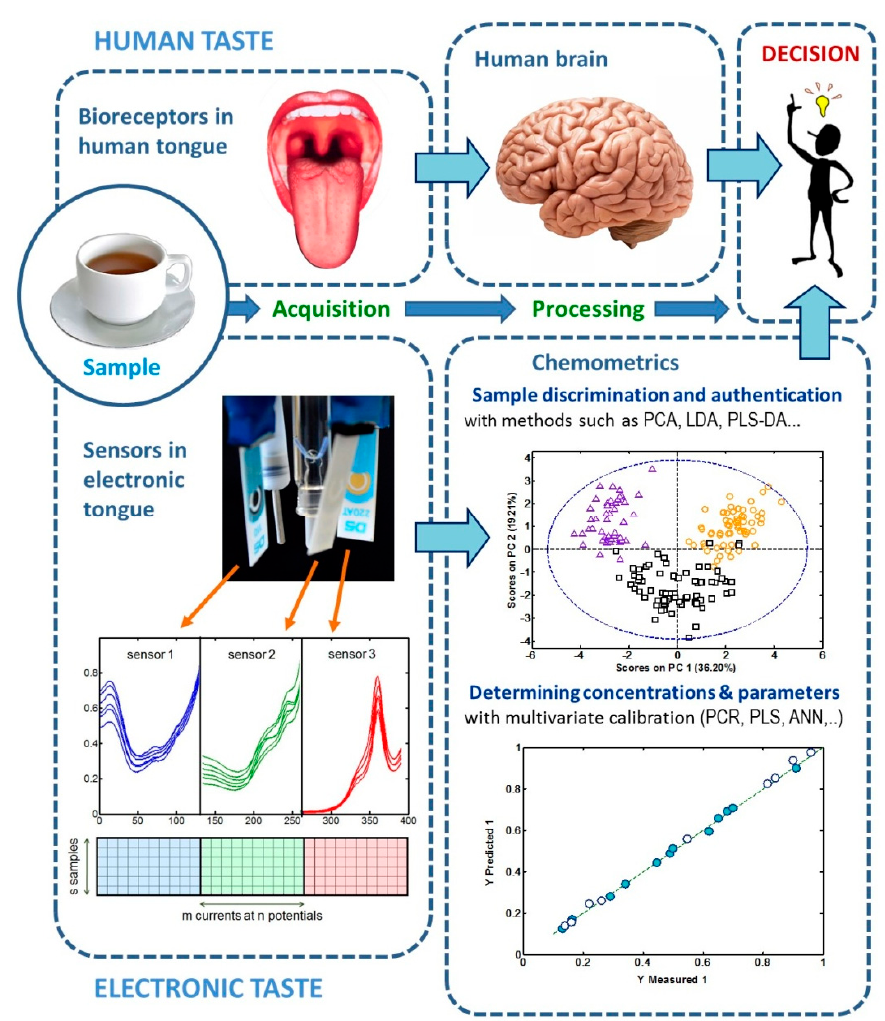
Figure 1. General scheme of voltammetric electronic tongues.